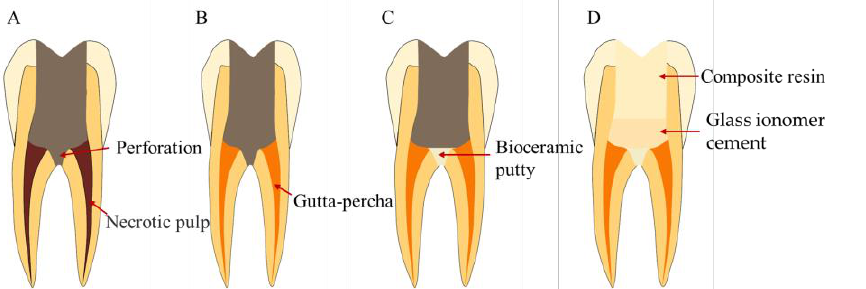
Figure 11. Treatment procedures for perforation repair. ( A ) Perforation in the floor of the pulp chamber. ( B ) Root canal therapy. ( C ) Perforation repair with bioceramics. ( D ) Coronal filling.